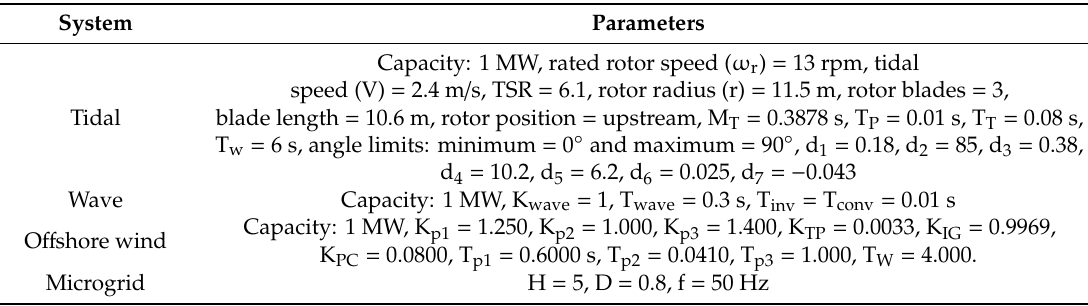
Table A1. Marine microgrid system